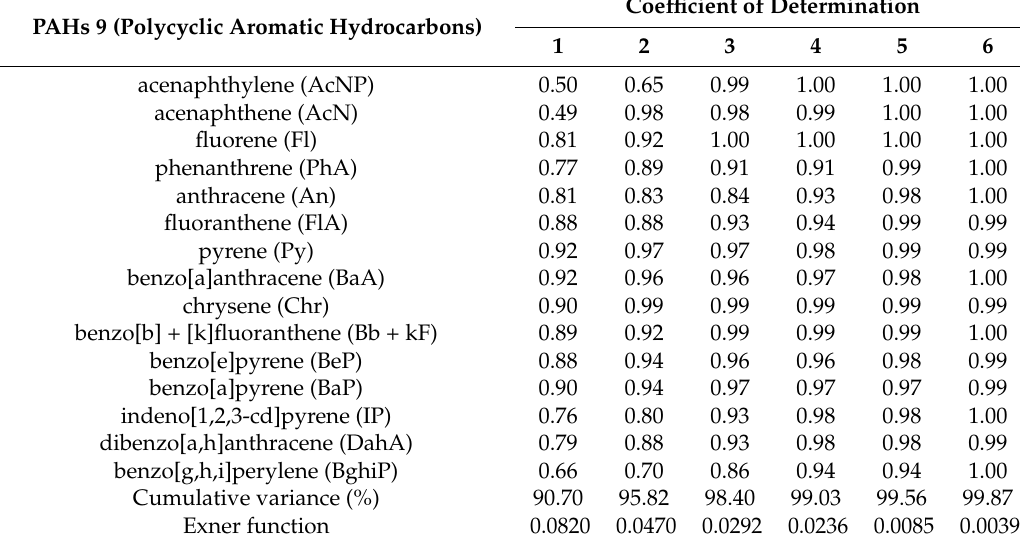
Table 1. Results of diagnostic tools application for the determination of the number of significant factors for the sediment of Dalian